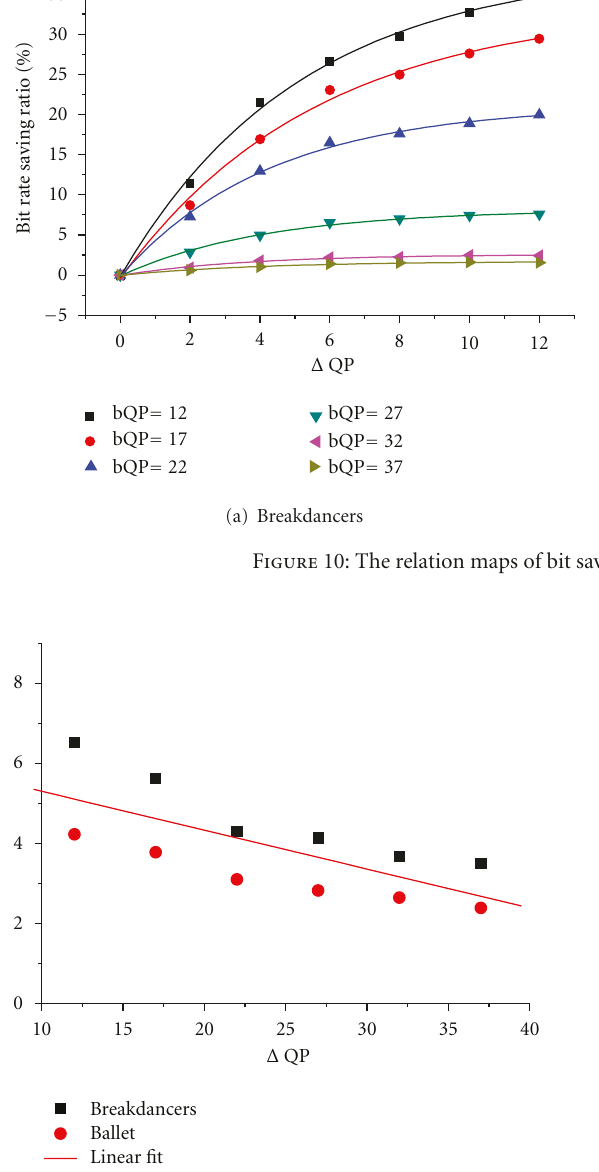
Figure 11: Relation map of bQP and coe ffi cient T . Figure 12: Relation map of bQP and coe ffi cient A